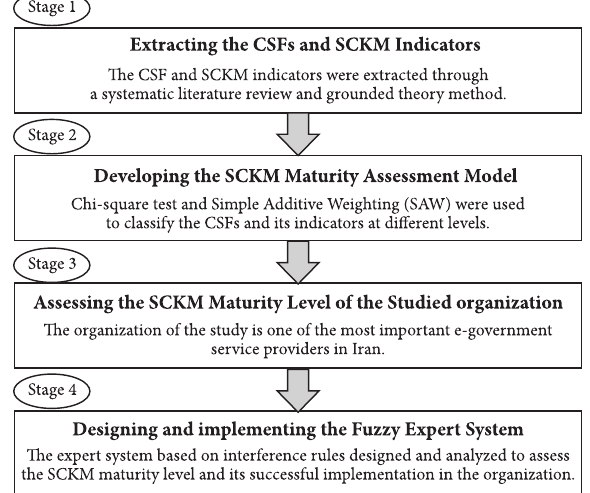
Figure 1. Research design